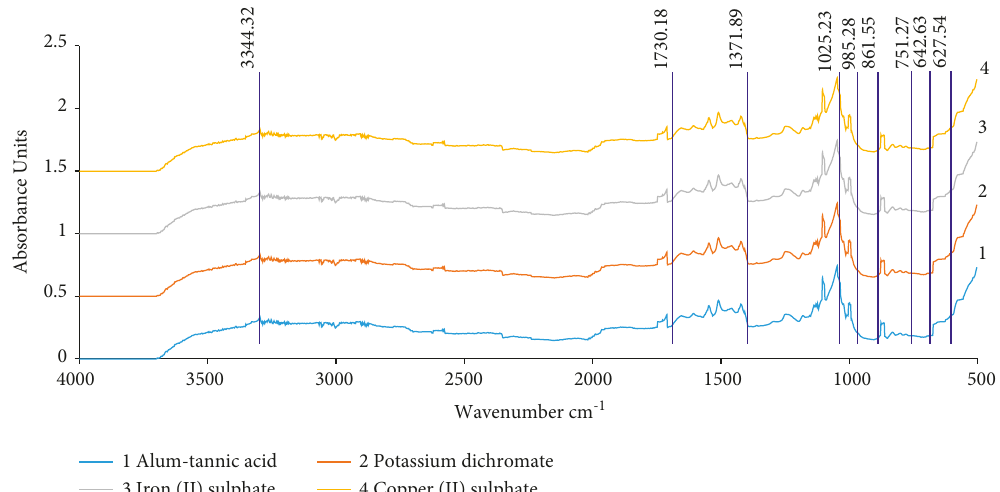
Figure 4: FT-IR spectra of the optimally dyed cotton fabric modified with natural mordant (1) and metallic mordants (2, 3, and 4).